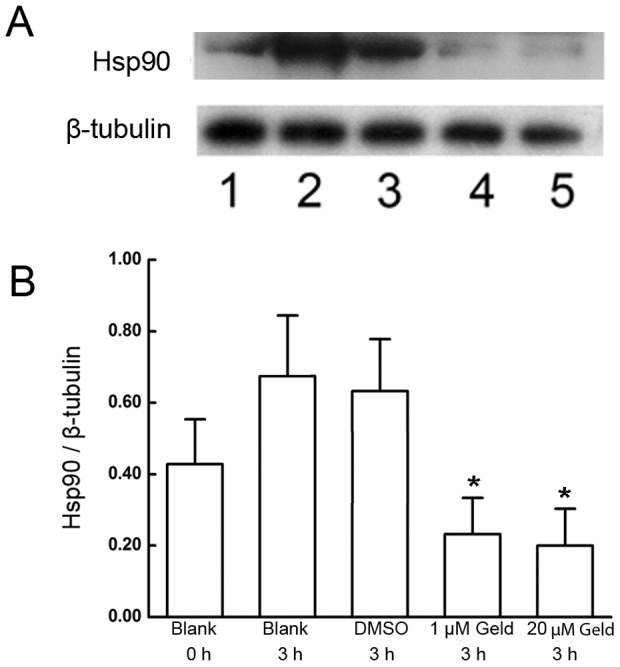
Effect of Geld on Hsp90 expression during capacitation.A) Under capacitation conditions, sperm were incubated in absence of geldanamycin (Geld) as a blank control for 0 h (lane 1) and 3 h (lane 2); with dimethyl sulfoxide (DMSO) as the vehicle control (lane 3), 1 µM Geld (lane 4), and 20 µM Geld (lane 5) for 3 h. Protein concentrations of sperm lysates were quantified using the Bicinchoninic Acid Assay Kit. Equal amounts of protein were resolved by SDS-PAGE, transferred to Immunoblot-P membrane, and probed with Hsp90 antibody. B) Band intensity ratios of Hsp90 to β-tubulin were lower in the Geld-treated sperm compared with that treated with the DMSO vehicle control, *P<0.05 (four independent experiments using ten different semen samples). Band intensities were measured using Image J software.